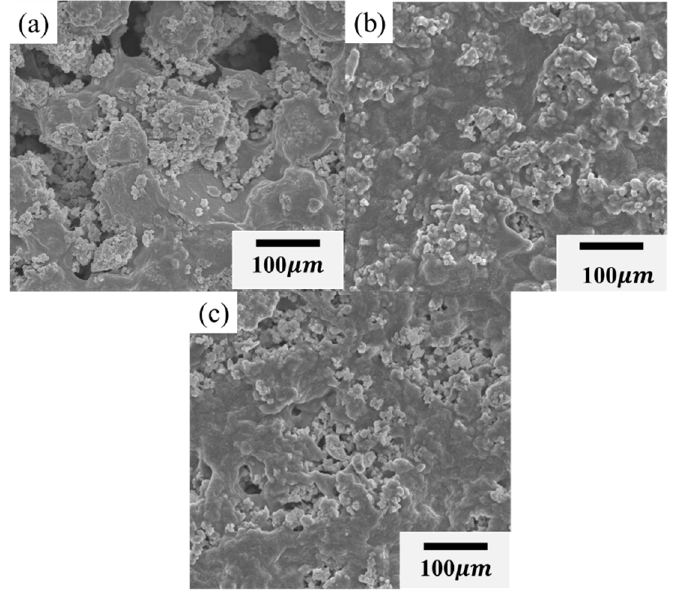
Figure 2. Field emission scanning electron microscopy (FE-SEM) images of electrolyte membranes